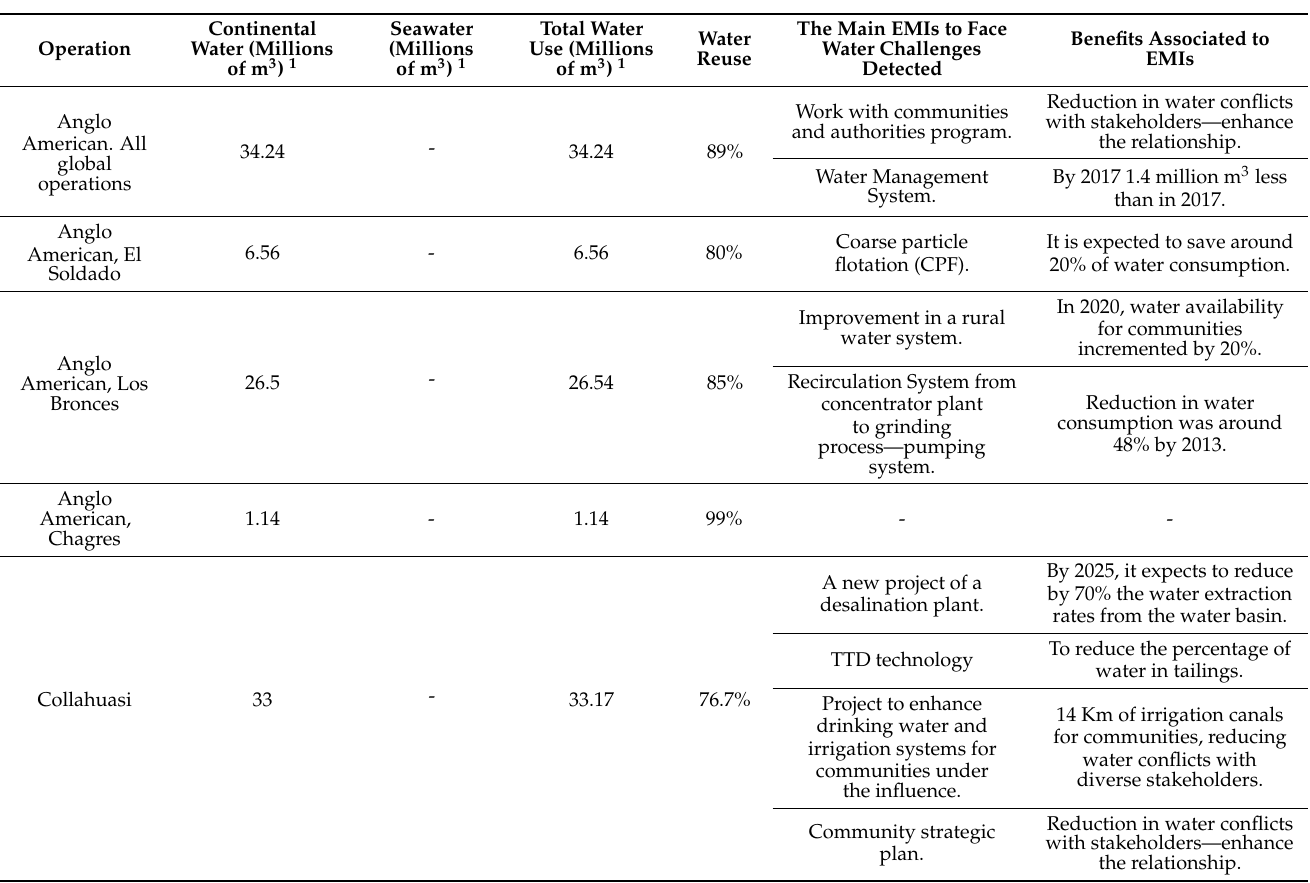
Table 3. Total water consumption and the main EMIs to deal with water challenges for each mining operation and their associated